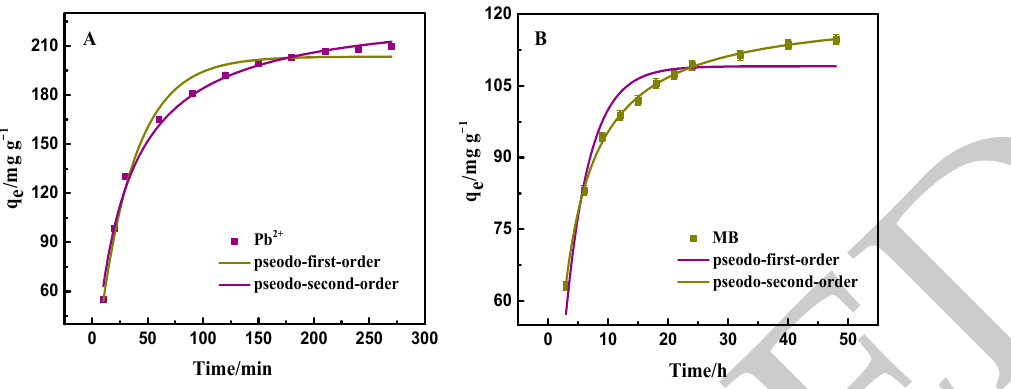
Figure 4. Adsorption kinetics of Pb 2+ and MB by PAA/LS/BC: pseudo-first-order kinetics ( A ) and pseudo-second-order kinetics ( B ).